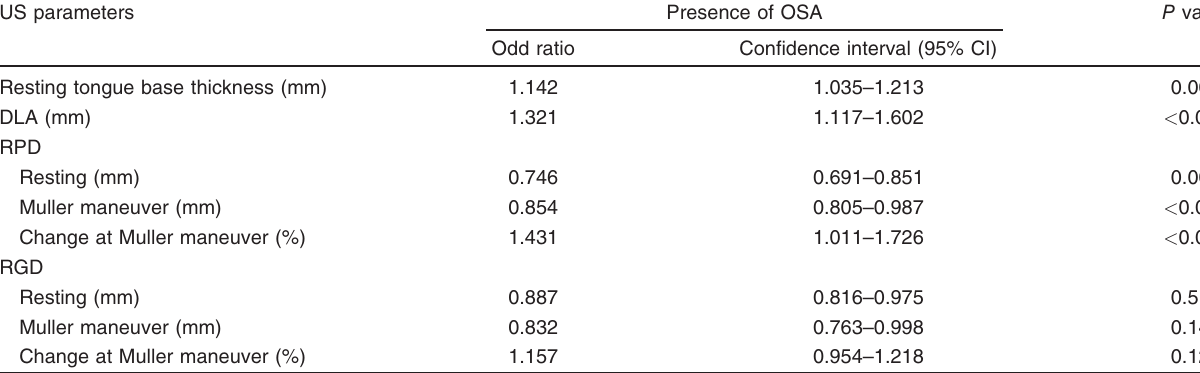
Table 8 Evaluation of the correlation and significance of the individual (univariate) anatomical and dynamic ultrasonography indices for diagnosis of obstructive sleep apnea US